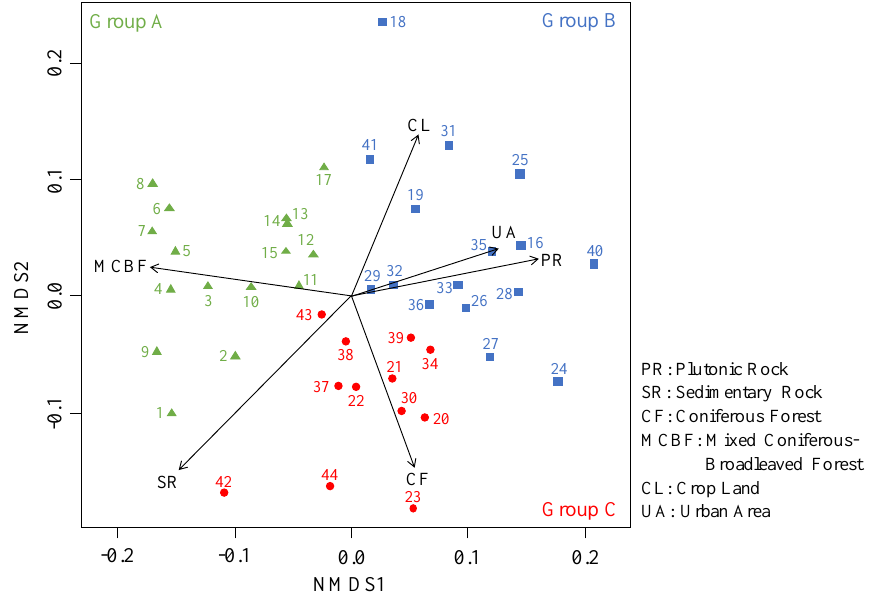
Figure 2. Result of NMDS using drought runoff coefficient of each occurrence probability. NMDS, nonmetric multidimen- sional scaling.